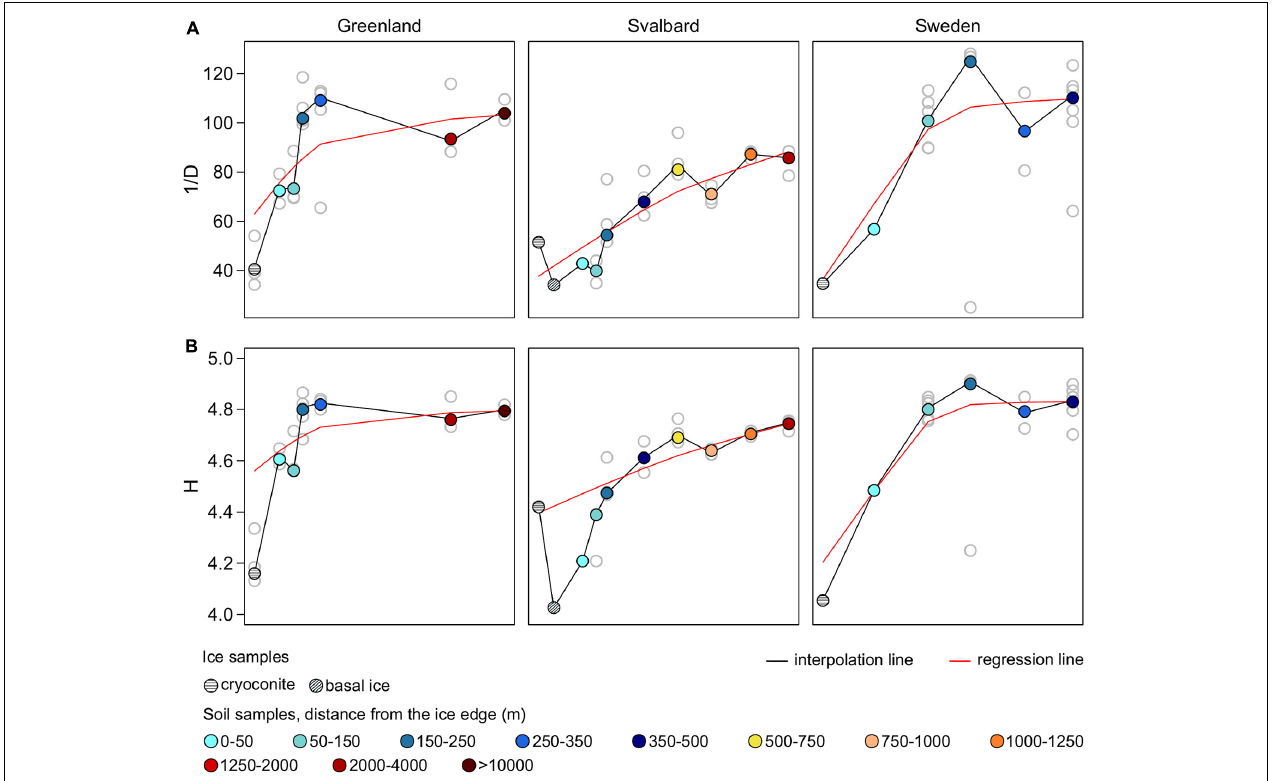
FIGURE 3 | Inverse Simpson’s (A) and Shannon’s (B) diversity indices (1/D and H) calculated on the genus-level taxonomic